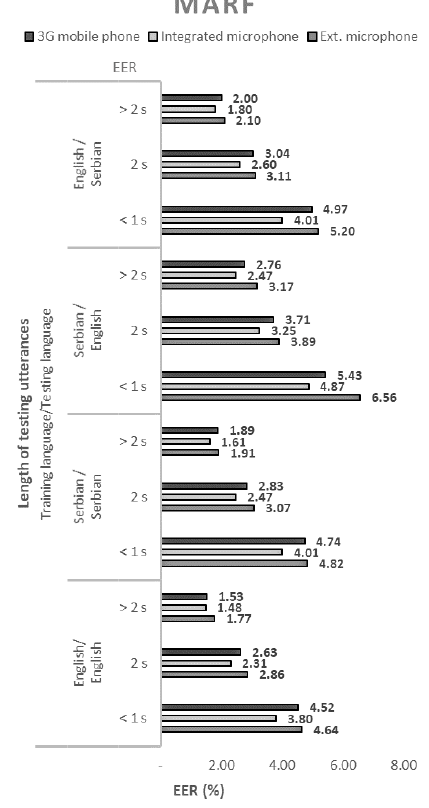
Figure 2. Equal error rates for the MARF speaker recognition model.